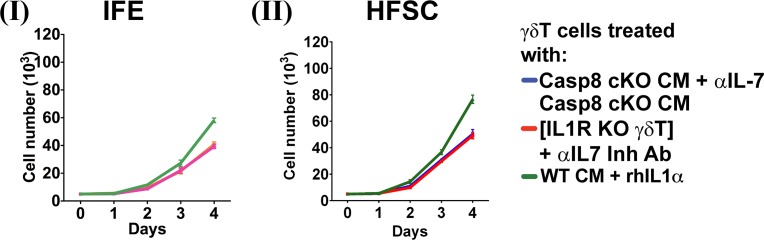
IFE and HFSC proliferation invoked by activated fibroblasts and γδT-cell-conditioned media.Proliferation rates of IFE (panel I) and HFSC cells (panel II) determined by trypan blue exclusion cell counting after treatment with CM from γδT-cells treated as indicated in the key.